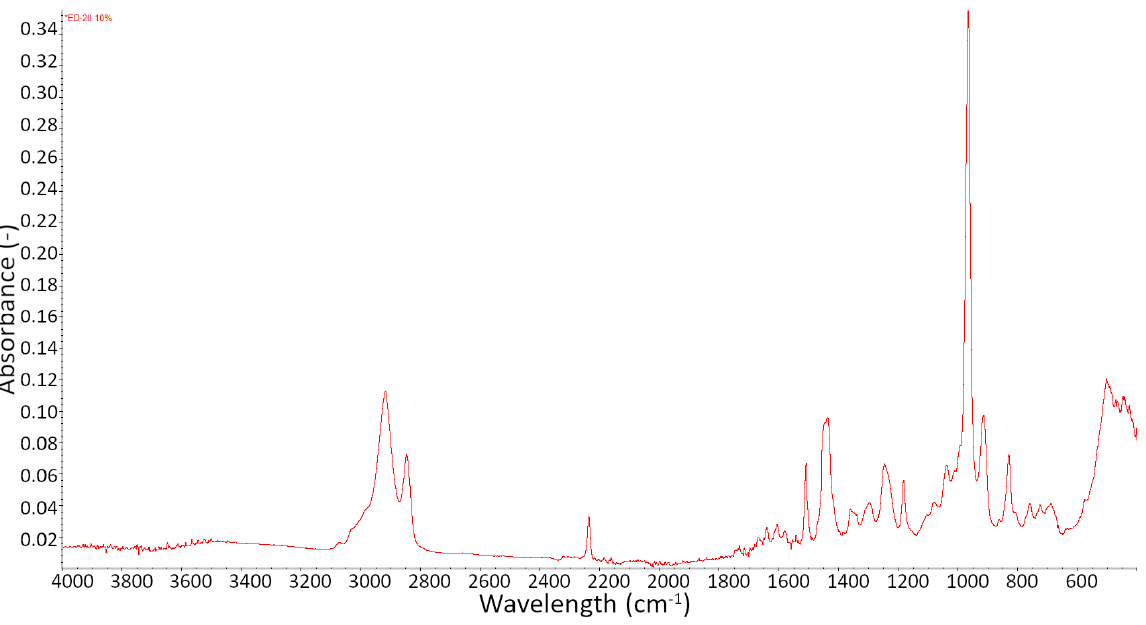
Figure 9. FT-IR spectrum of NBR modified with 10 wt.% ED-20 after vulcanization. In the case of the sample containing 15% of the resin, one can witness another increase in the intensity of the peaks coming from the resin. In the FT-IR spectrum of ED-24 AK sample, one can see relatively high peaks from NBR rubber and small peaks from a resin (Figure